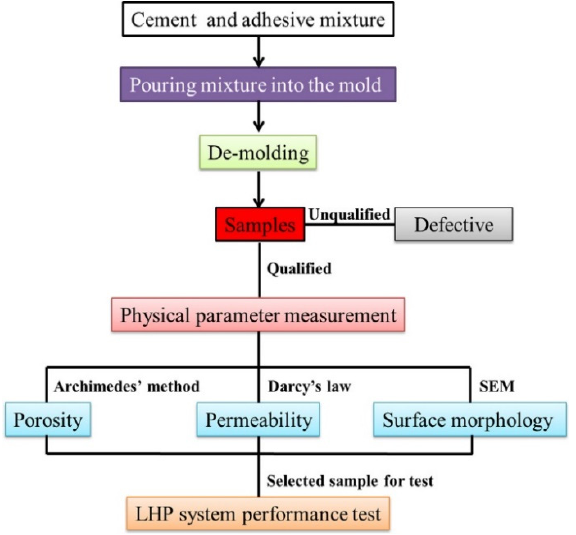
Figure 2. Flow chart of pouring porous wick fabrication by He et al. [4].